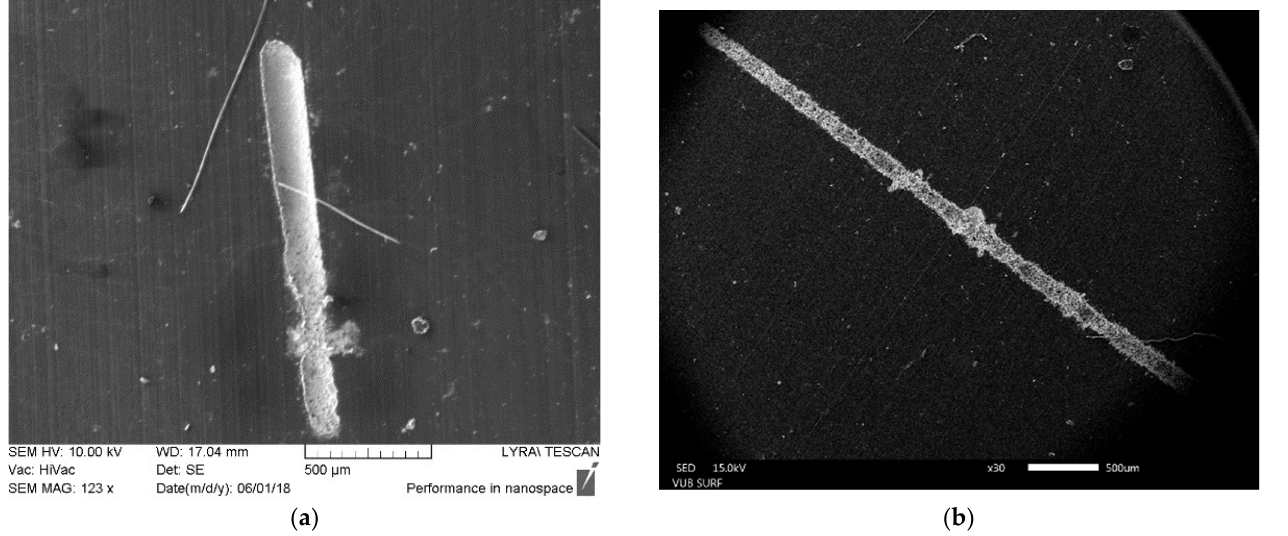
Figure 2. SEM images of tracks with worsening morphologic quality obtained on PDMS surface by laser ablation in water with wavelengths of: ( a ) 266 nm and 28.07 J.cm −2 and ( b ) 355 nm and 30.83 J.cm −2 when bubbles are induced in the zone of the laser beam spot. The tracks are metalized with Pt.